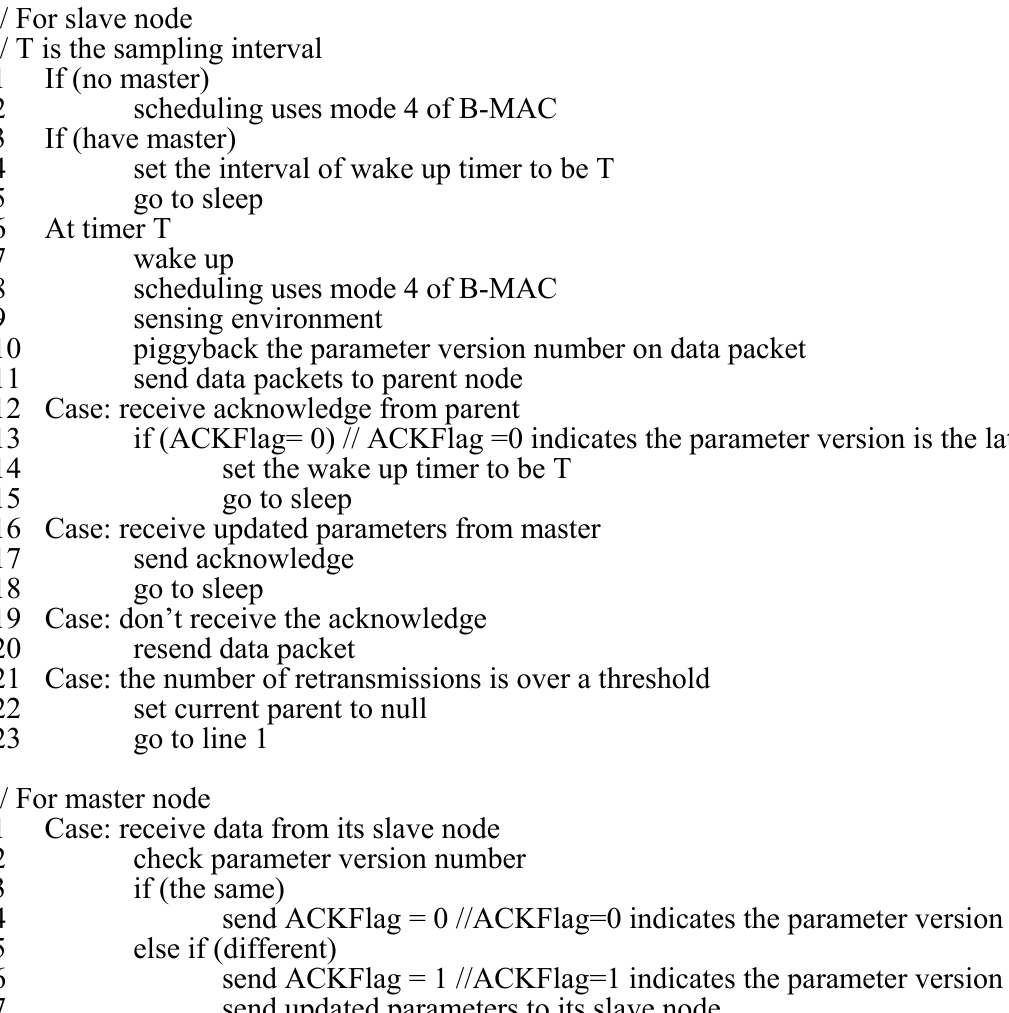
Figure 8. The pseudo code of the proposed